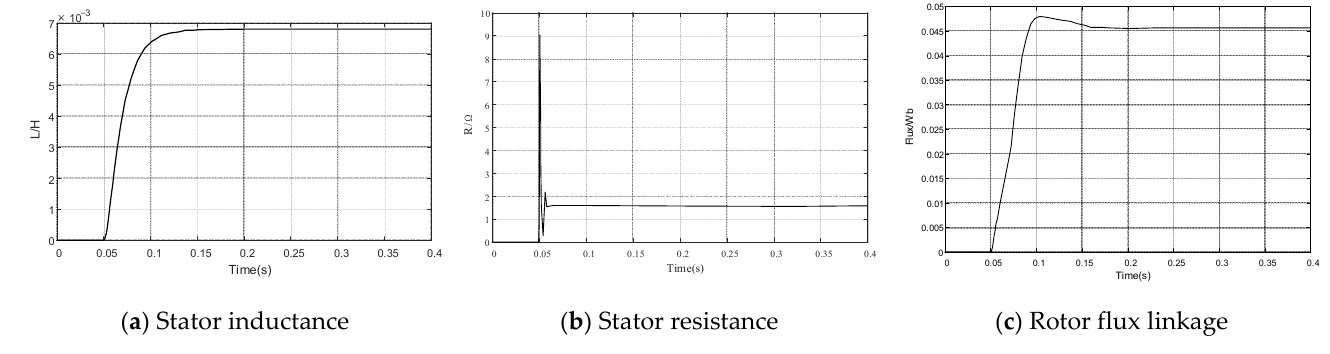
Figure 10. Parameter identification curve.